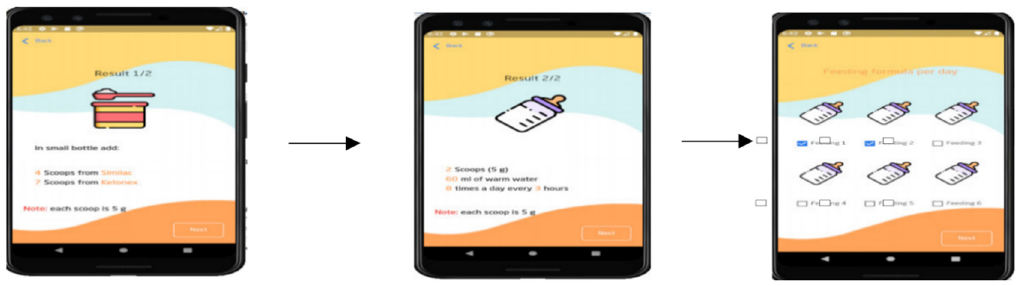
Figure 5. Recommending the appropriate daily doses of formula.